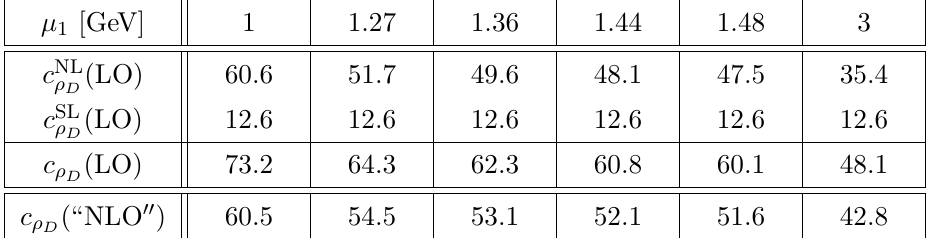
, c NL , and c = c SL + c NL for different values of the renormali- ρ D ρ D ρ D ρ D ρ D = m = 1 . 5 0 c